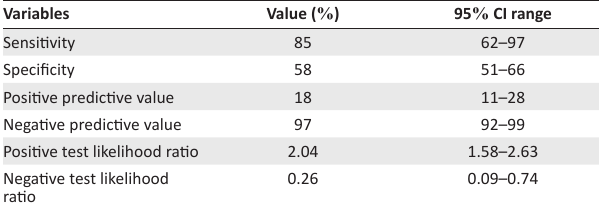
TABLE 6: Sensitivity, specificity, positive- and negative predictive values and likelihood ratios of positive and negative test of the movement assessment battery for children - second edition performance test and the movement assessment battery for children - second edition checklist.